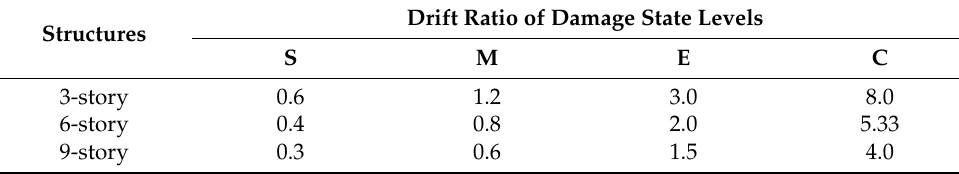
Table 4. Percentage of drift ratio for high-code design level